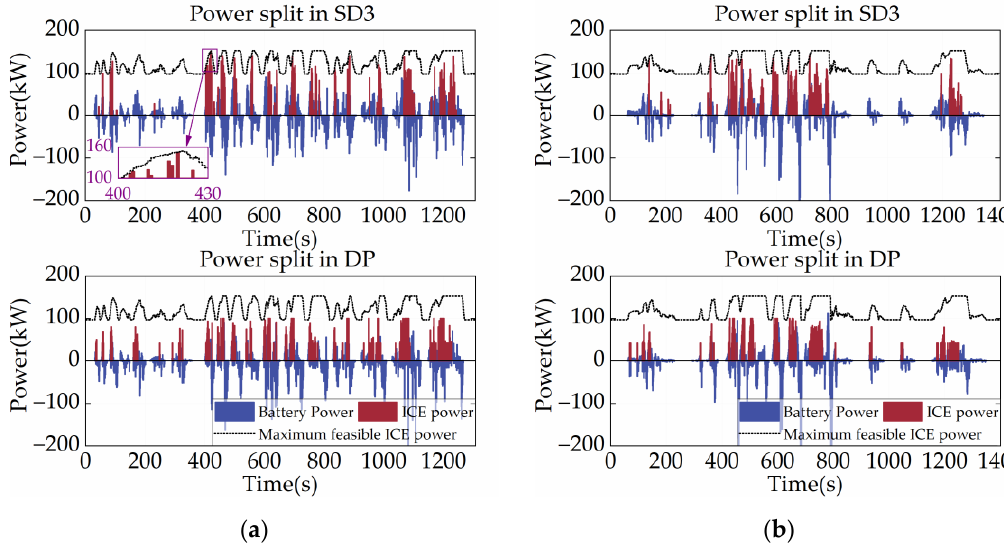
Figure 10. Power allocation under different driving cycles. ( a ) CHTC-B; ( b ) WVUCITY.